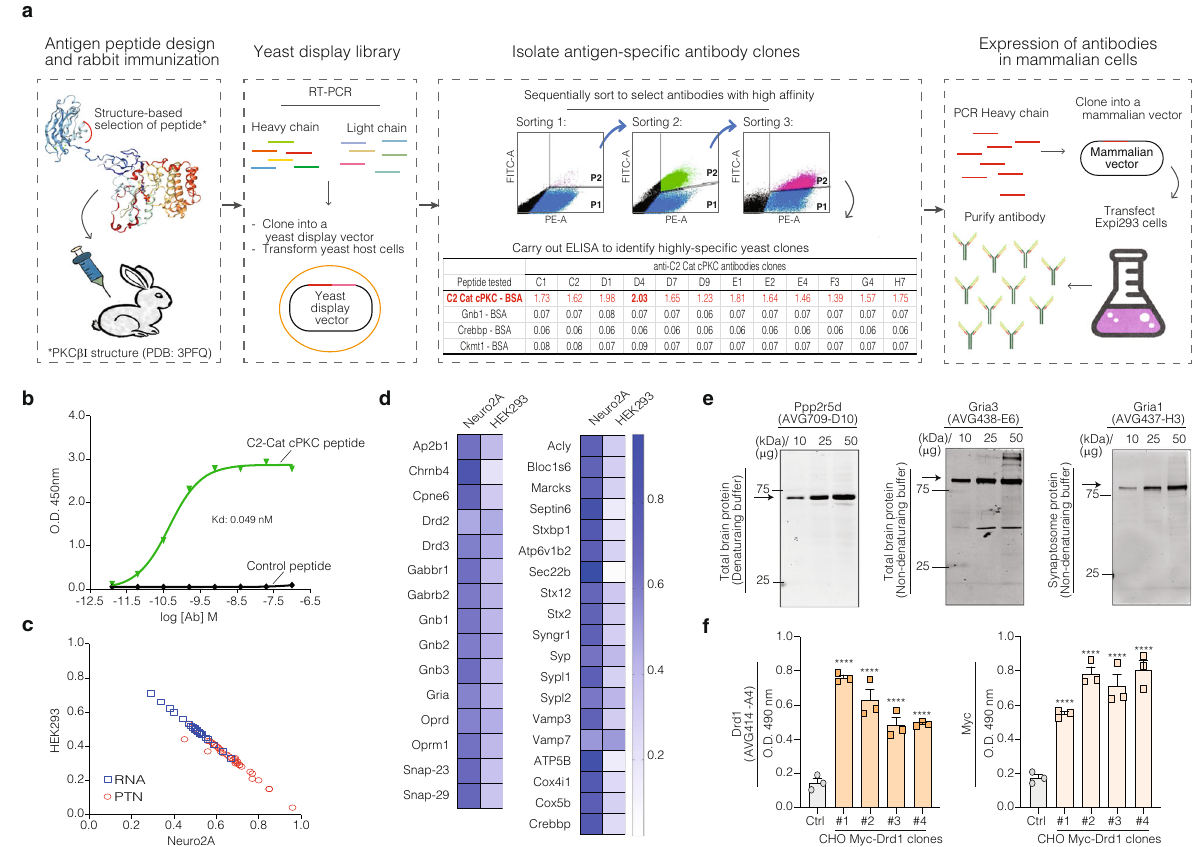
Fig. 2 Work fl ow of recombinant antibody development and different approaches for its validation. a Antibody development was strati fi ed into four steps: peptide design 23 and rabbit immunization; construction of the yeast antibody display library; isolation of antigen-speci fi c antibody clones and expression of recombinant antibodies in mammalian cells. b Binding curve of a puri fi ed antibody clone, anti-C2-Cat-cPKC (AVG459-D4), to immobilized C2-Cat-cPKC peptide compared to control peptide. c Correlation analysis between the relative expression levels of mRNA expression (blue square) and protein (red circles) in Neuro2A cells ( x -axis) and HEK293 cells ( y -axis). mRNA expression was obtained from the GeoPro fi le Dataset (GDS5140 for Neuro2A cells, and GSD4233 for HEK293 cells). The protein levels (PTN) were measured by ELISA using the newly developed antibodies. The relative expression is the mean of the sample measurement divided by the sum of the Neuro2A and HEK293 cell values (RANK for mRNA, O.D. for protein), from three experiments. R 2 0.95 and p value < 0.0001. d Heatmap of relative protein expression from Neuro2A and HEK293 cells. Darker blue squares indicate higher expression levels from ELISA experiments. The ELISA was performed using the rAbs against the proteins listed in the heatmap. Data are mean ± SE of three experiments. e Western Blot analysis from total brain and synaptosomal protein extracts at different protein concentrations and buffers. f ELISA using CHO cells and different clones of CHO cells overexpressing Drd1 with a N-terminal Myc-tag. The ELISA was performed using antibodies speci fi c for the Drd1 receptor (AVG414-A4) and for the Myc-tag. Data are mean ± SE of three experiments, P value < 0.0001; One-way